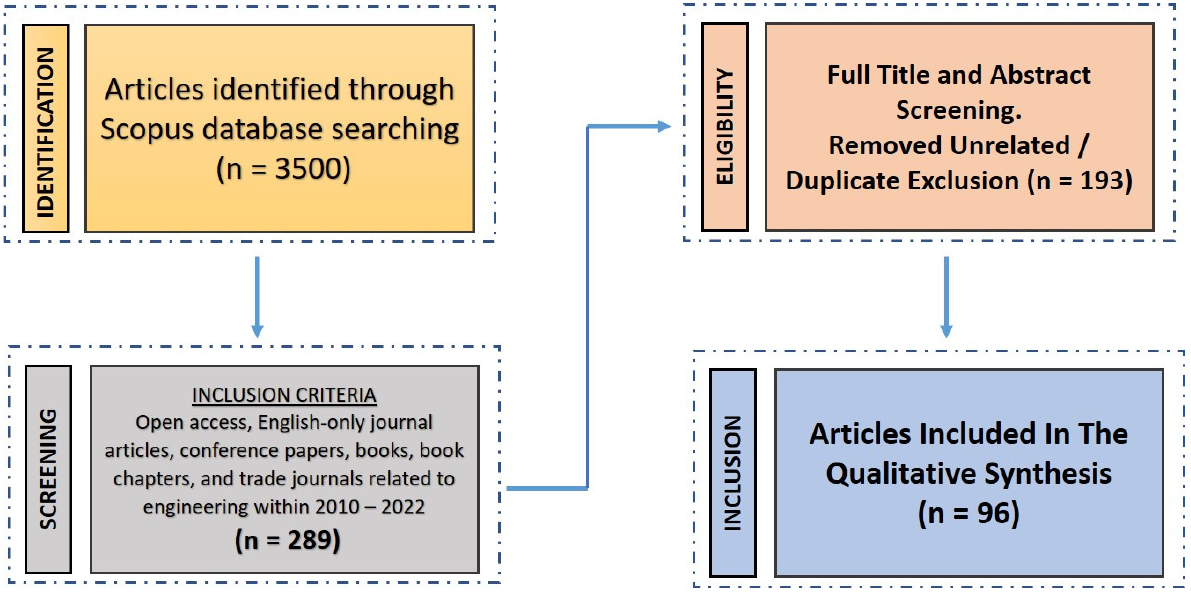
Figure 1. PRISMA framework article collection process (n = number of articles).